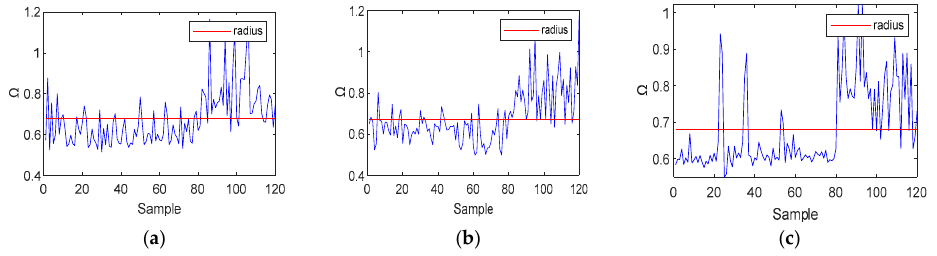
Figure 6. The results of the S-SVDD method for pipeline leak detection. ( a ) small leak; ( b ) medium leak; ( c ) large leak.